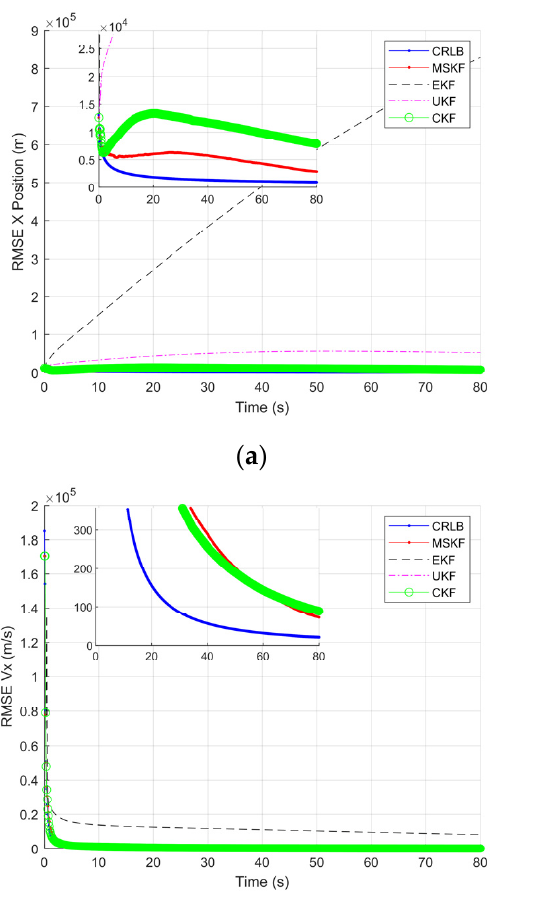
15 of 17 Figure 8. Range estimation accuracy of CL distribution. Figure 9. Angle estimation accuracy of CL distribution. The state component estimation RMSE and theoretical performance lower bound CRLB is given in Figure 10. Due to the non-Gaussian measurement distribution, the initial RMSE of the four filters and CRLB are all large. As the iteration progresses, the UKF, CKF, and MSKF proposed in this paper gradually converge to steady-state, while the range accuracy of the EKF gradually diverges. The steady-state value indicates the approxima-